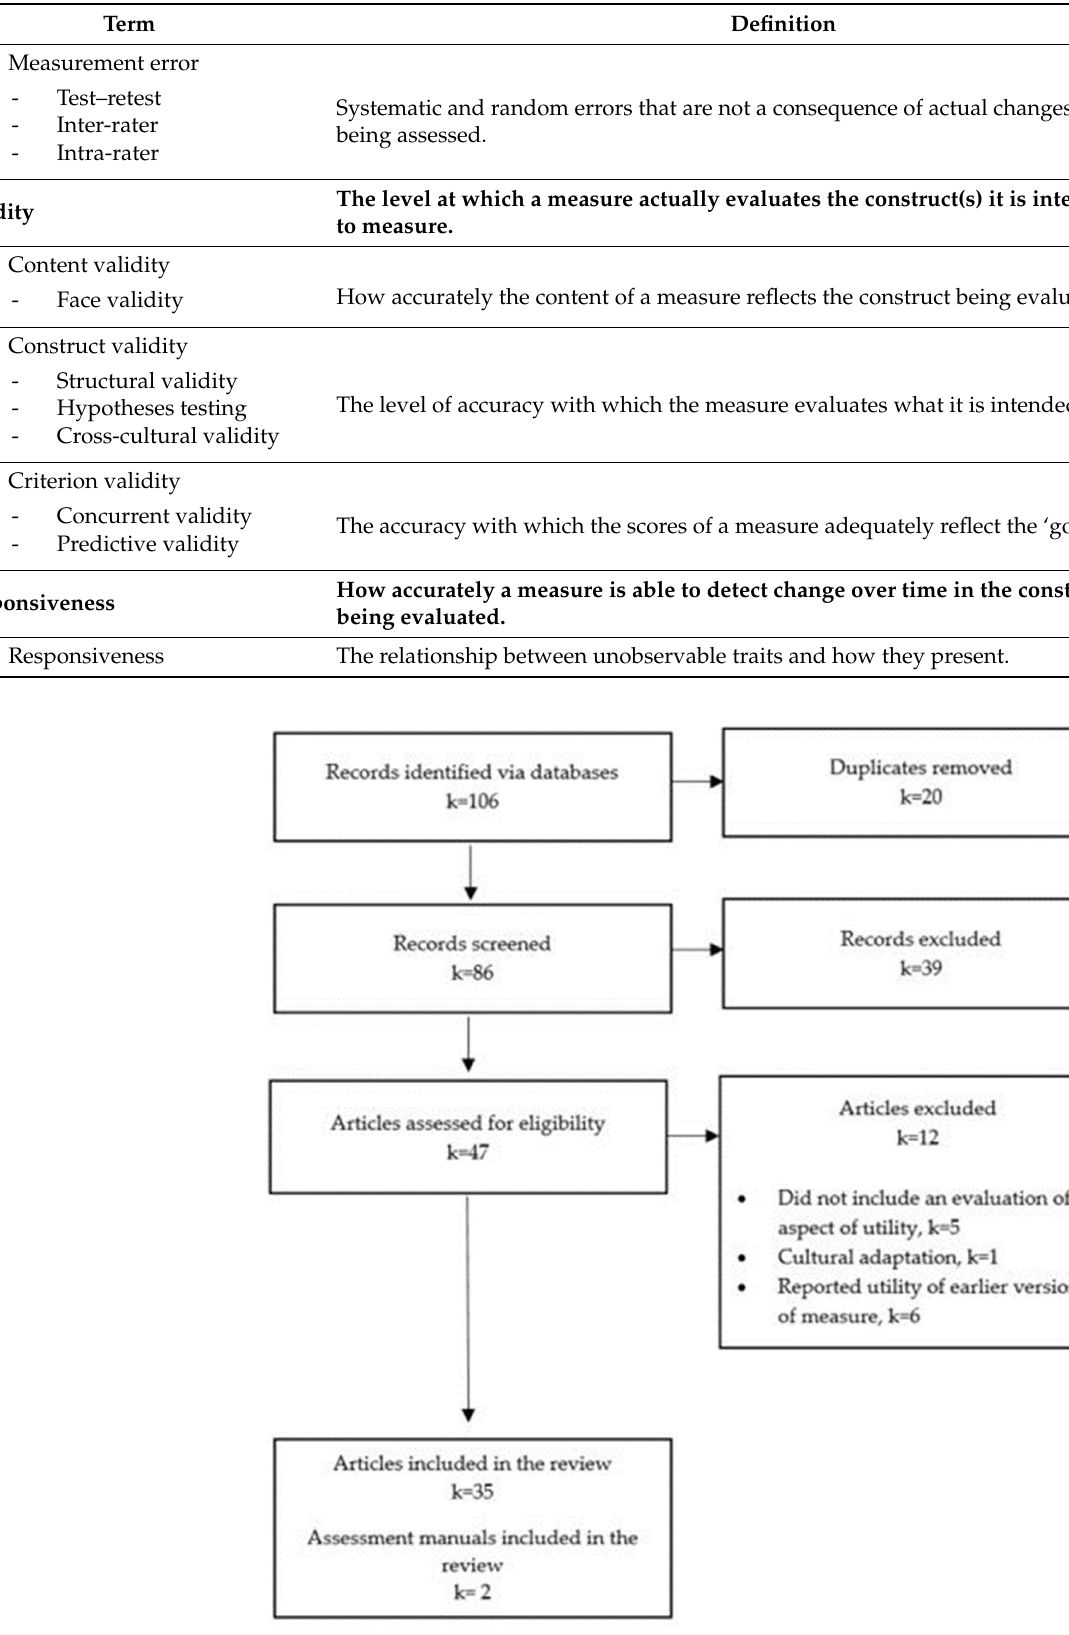
Figure 2. Phase Two, measures of functioning identification and screening